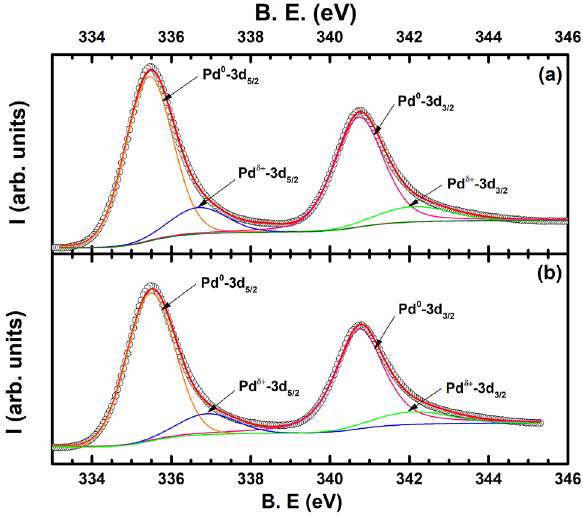
Figure 10. XPS spectra of the 5 nm thin film ( a ) before and ( b ) after exposure to 5000 ppm of H 2 gas for 1 hour. Open black circles denote the data while the thick red solid line is a fit to the data. Thin solid lines in each denote the spectral decomposition of the spectra in peaks corresponding to Pd 0 -3d 5 ∕ 2 (orange), Pd 0 -3d 3 ∕ 2 (pink), Pd 𝛿 + -3d 5 ∕ 2 (blue) and Pd 𝛿 + -3d 3 ∕ 2